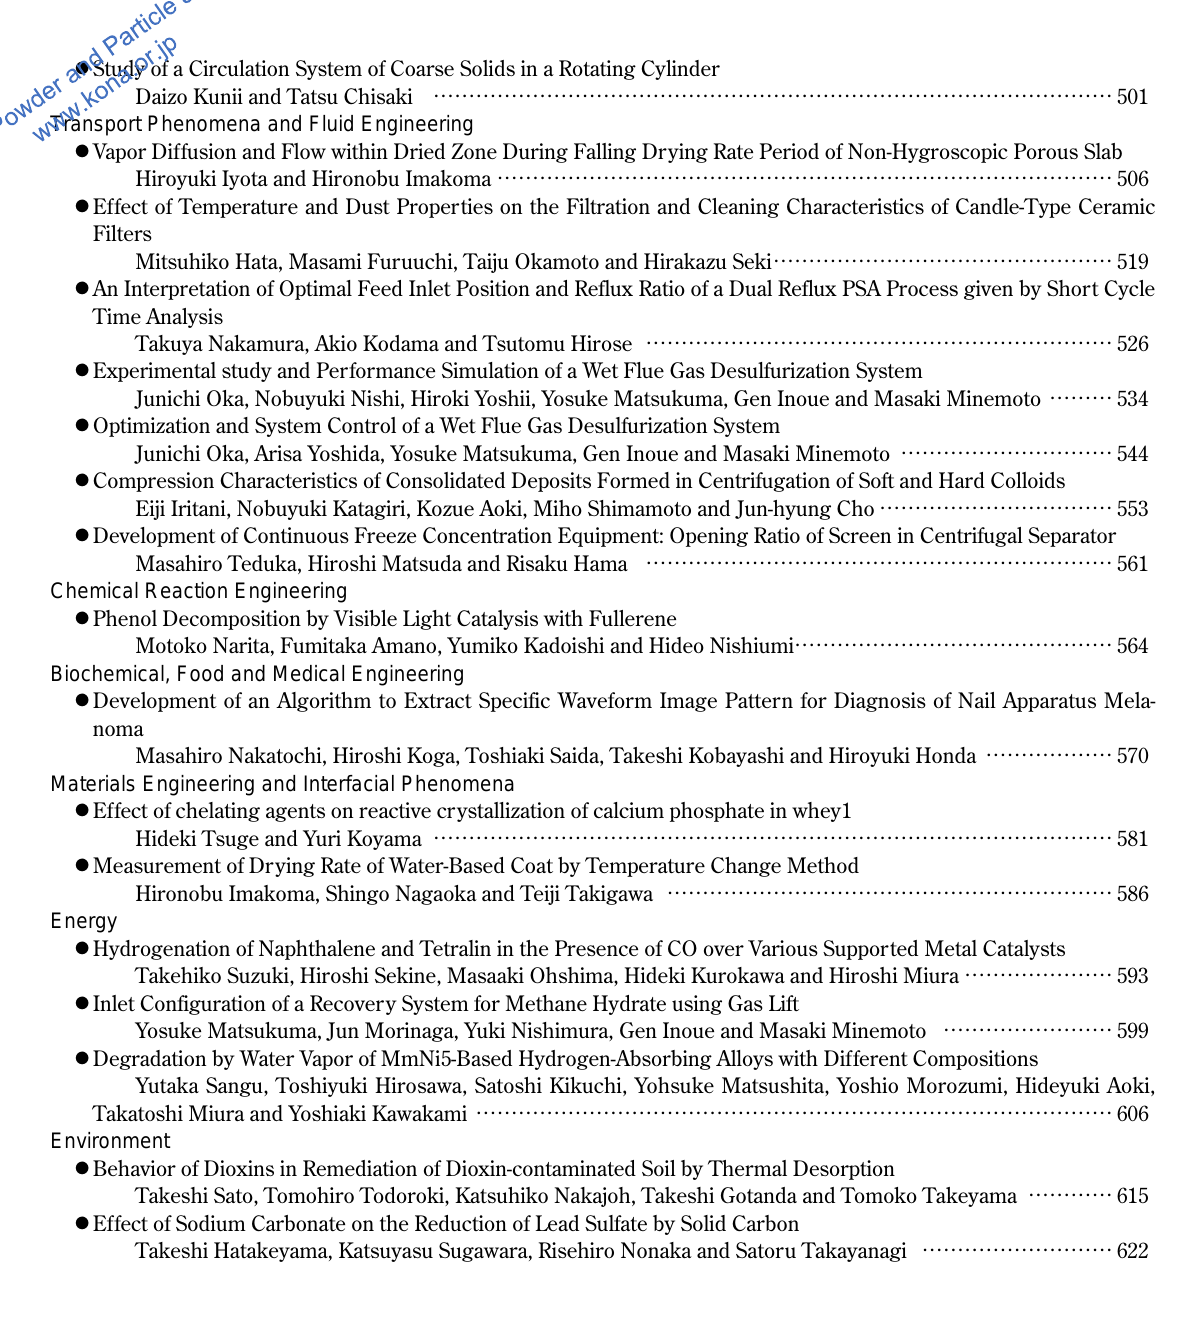
・ Vapor Diffusion and Flow within Dried Zone During Falling Drying Rate Period of Non-Hygroscopic Porous Slab